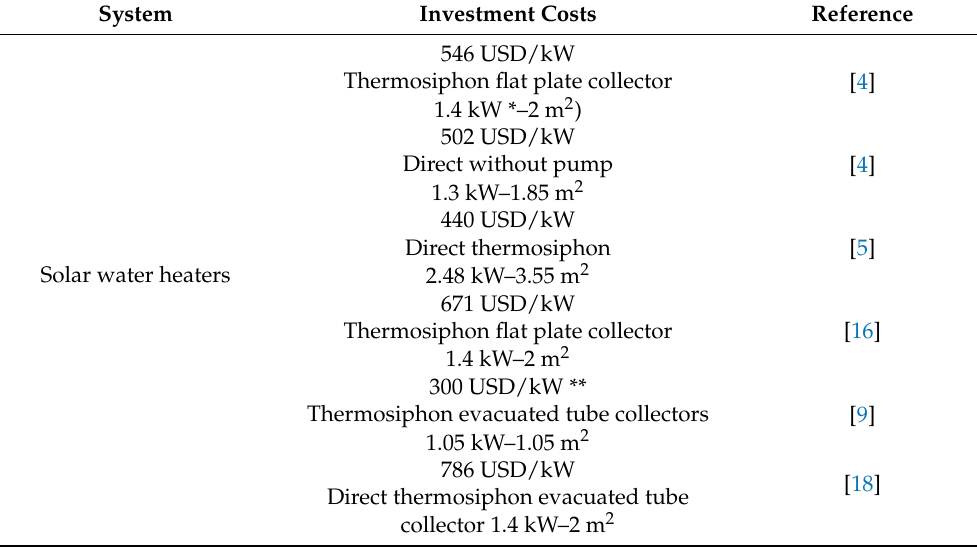
Table 3. Investment costs (DHW